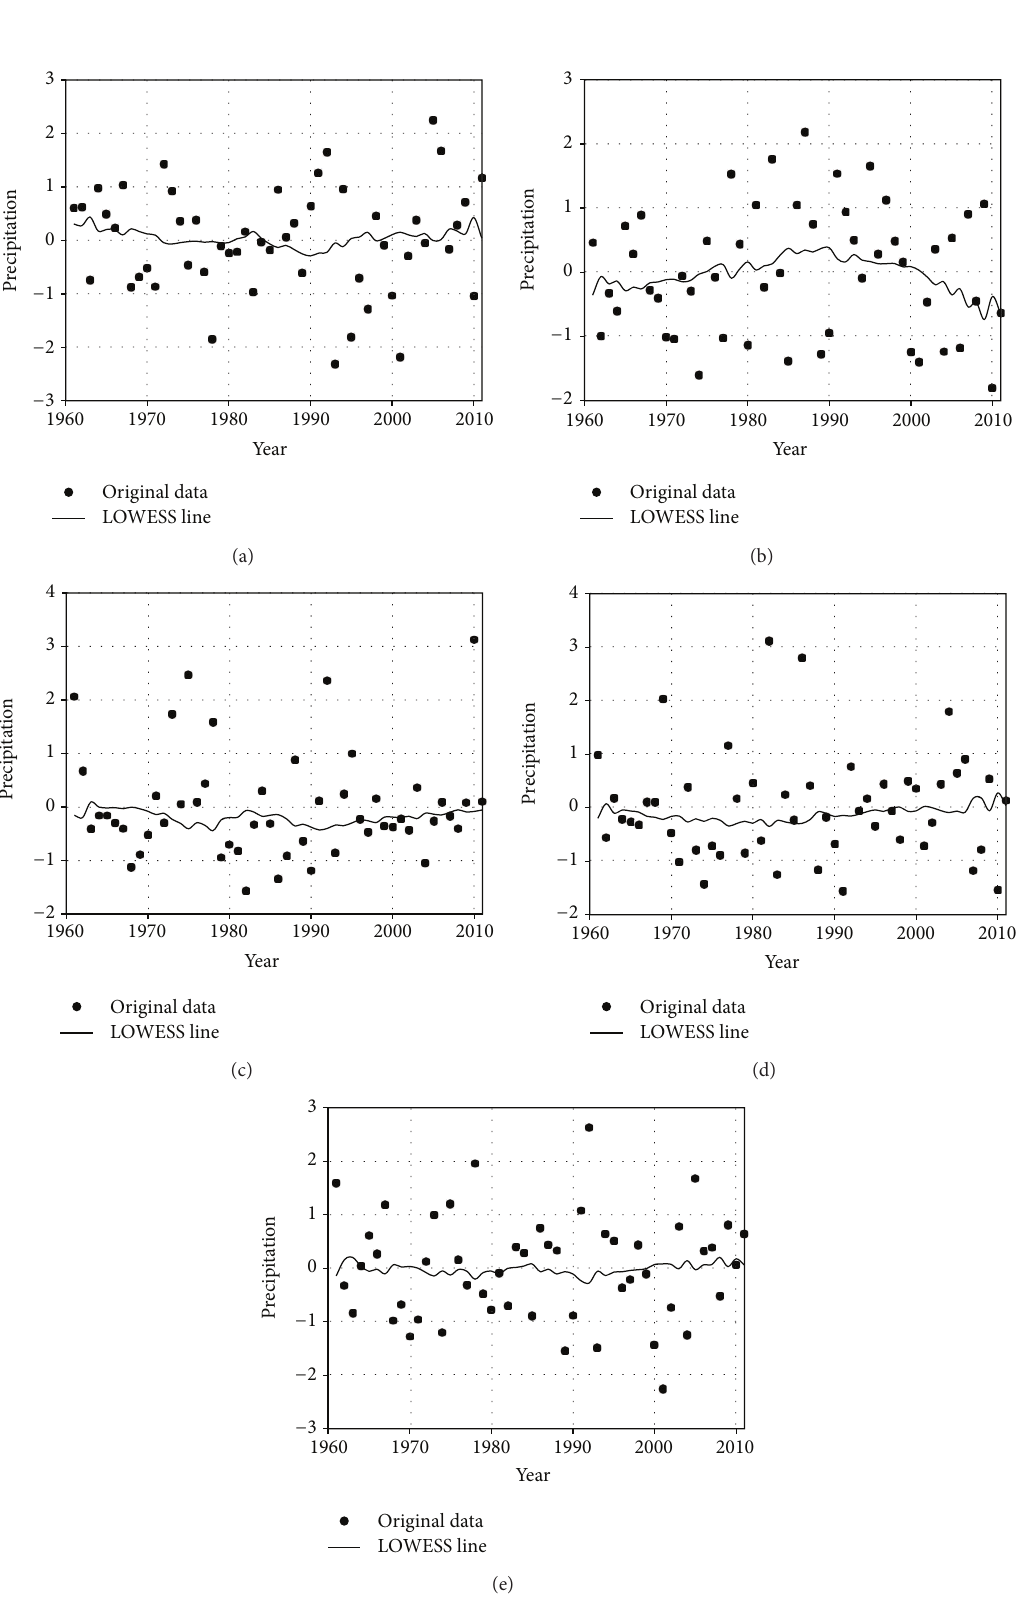
Figure 2: Standardized precipitation and LOWESS trend curves at Swat River basin: (a) winter, (b) spring, (c) summer, (d) autumn, and (e)